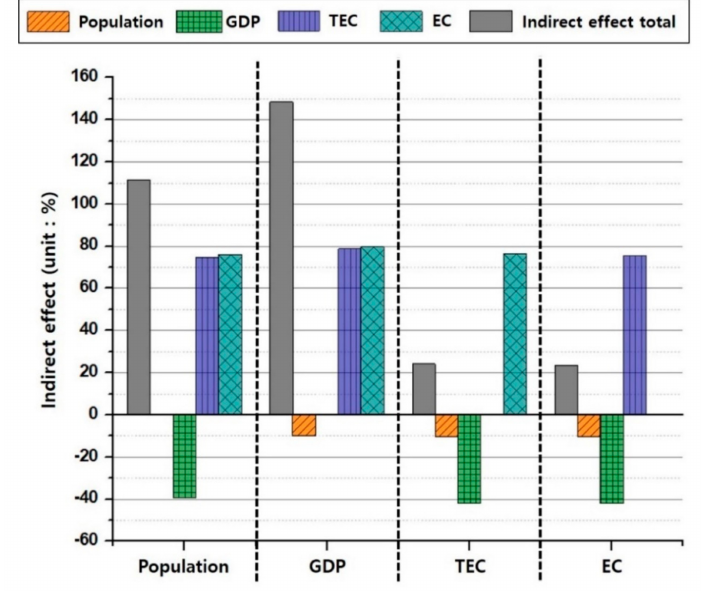
Figure 2. Comparisons of indirect effects among the decomposed variables of Kaya identity factors on F Foss